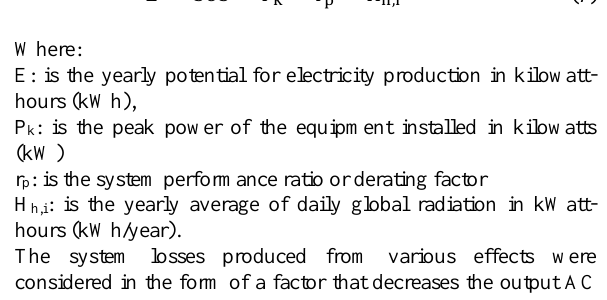
Figure 5 . The relation between GCR and derate factor caused by inter-row shading graph (Seminole Financial Services,